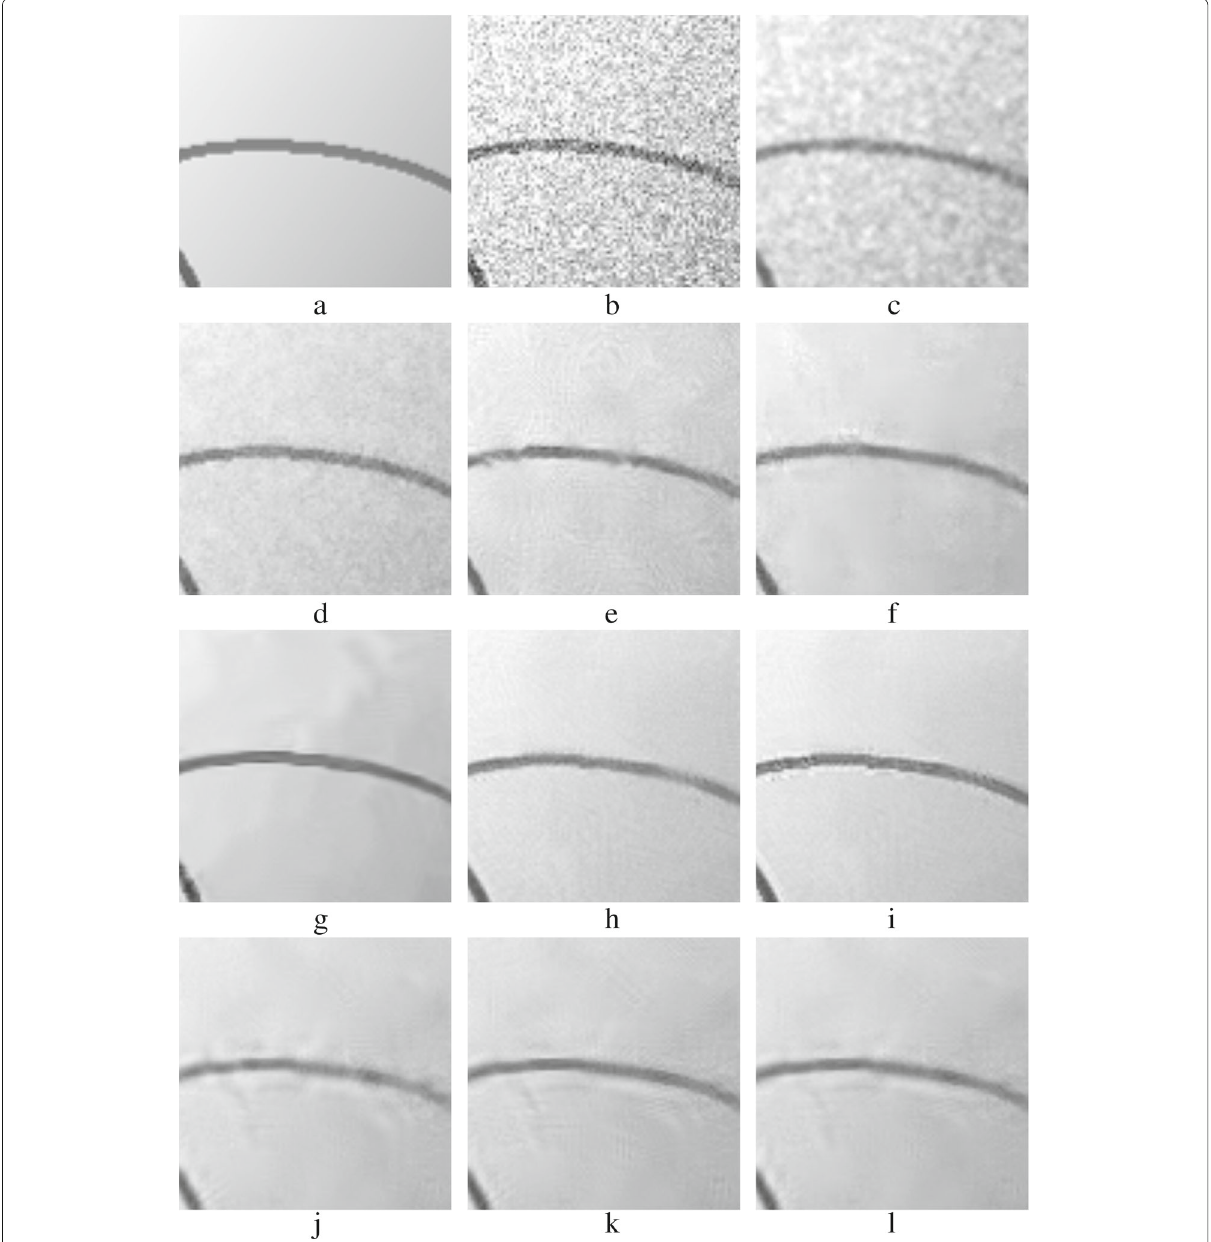
Fig. 20 Zoomed images of the denoised CurvedBand image shown in Fig. 19: a original CurvedBand image; b AWG noise, σ = 40 c AD (Perona & Malik); d bilateral filtering; e NL-Means filtering; f K-SVD; g BM3D; h Non-itPPB; i It-PPB; j PGPCA; k PLPCA; and l